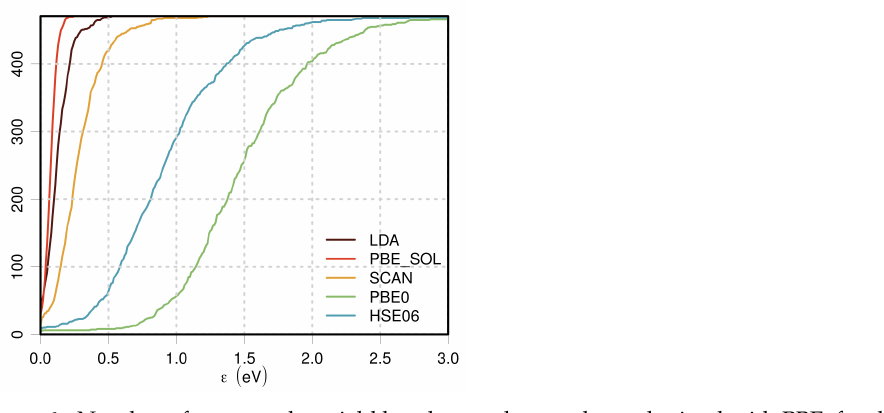
Figure 6. Number of systems that yield band gaps close to those obtained with PBE, for different methods, as a function of (cid:101) .